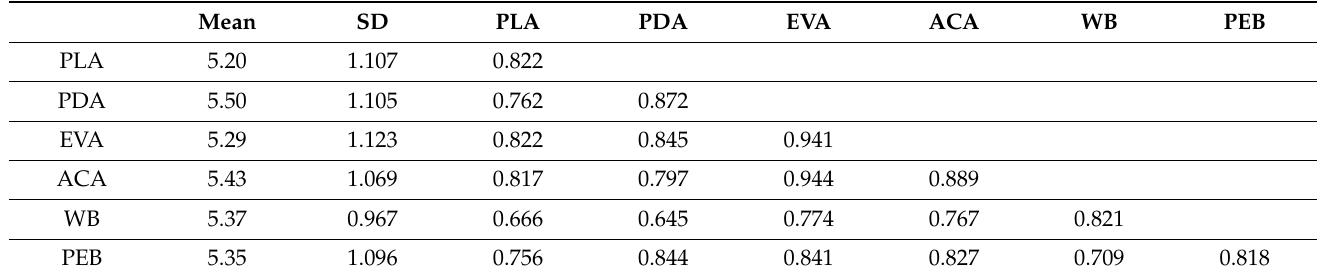
Table 3. Discriminant validity of the constructs.